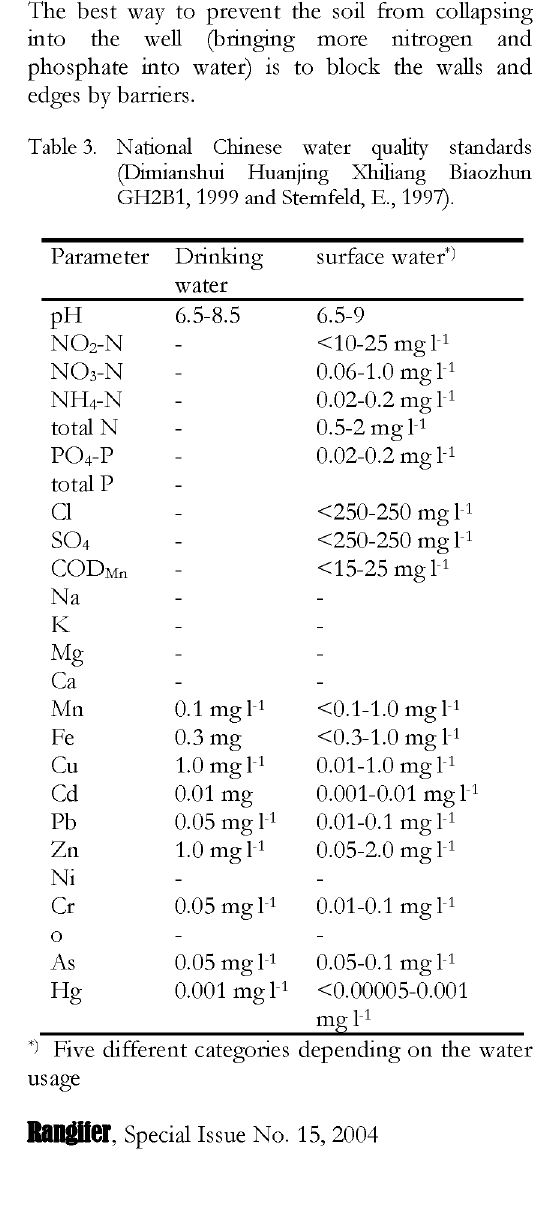
Table 3. National Chinese water quality standards (Dimianshui Huanjing Xhiliang Biaozhun GH2B1, 1999 and Sternfeld, E.,